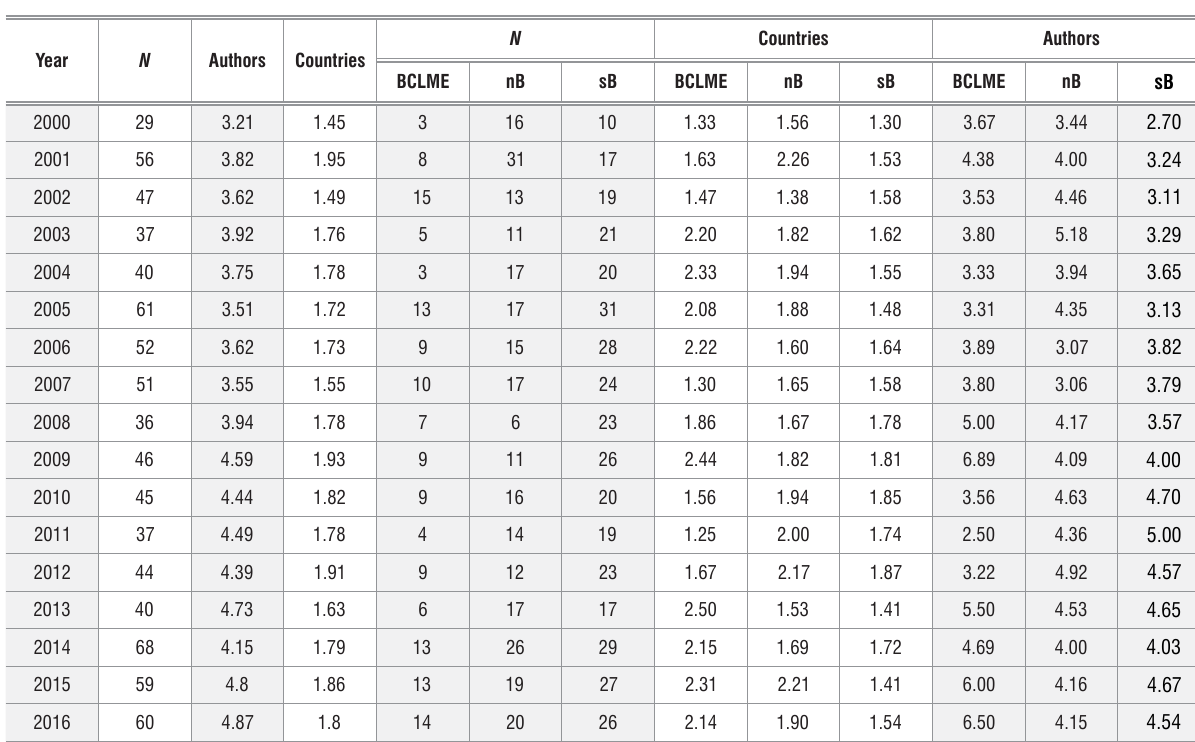
Number of papers ( N ) published on the resources and/or the environment of the Benguela Current Large Marine Ecosystem (BCLME) region over the period 2000–2016. Also shown are the average number of authors per paper and the average number of participating countries per paper. Data subdivided by study focus area: BCLME, region wide; nB, northern Benguela; sB, southern